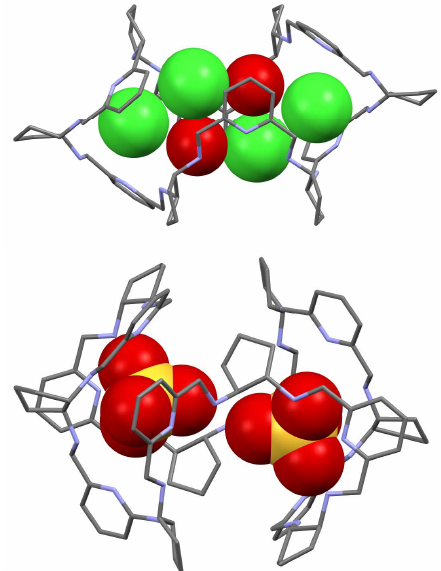
Figure 26. Expansion of the [2 + 2] macrocycle into giant meso -type macrocycles.